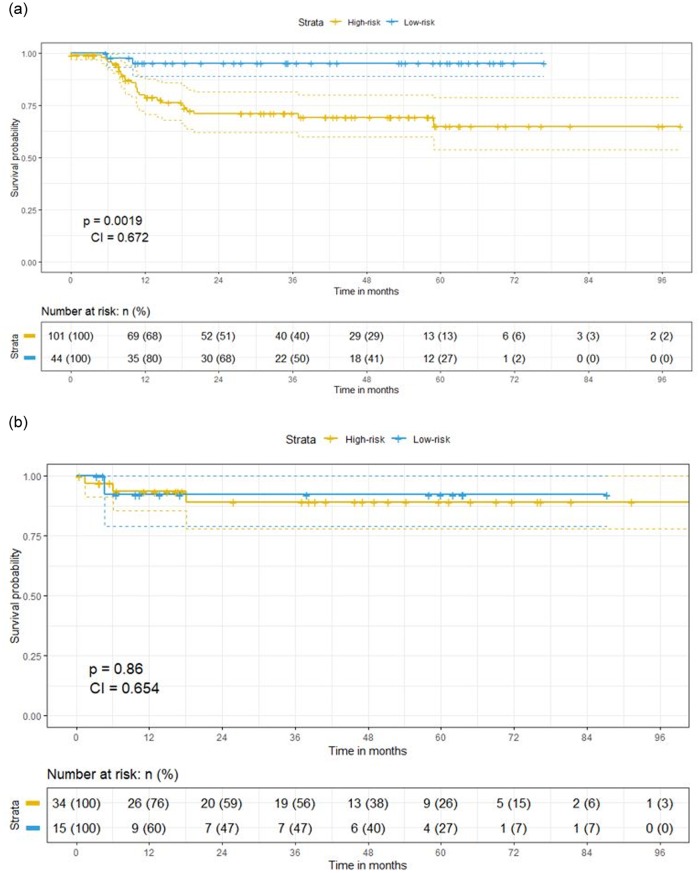
a. Training Kaplan-Meier (distant metastasis free) survival split for oropharyngeal patients (best performing clinical model in validation with Cox regression, oropharynx-DM) based on above (blue line) and below (yellow) median prediction probabilities. b. Validation Kaplan-Meier (distant metastasis free) survival split for oropharyngeal patients (best performing clinical model in validation with Cox regression, oropharynx-DM) based on above (blue line) and below (yellow) median prediction probabilities. Non-significant split in survival according to median in training, though in all of the above median cases the time to event is not observed (censoring).